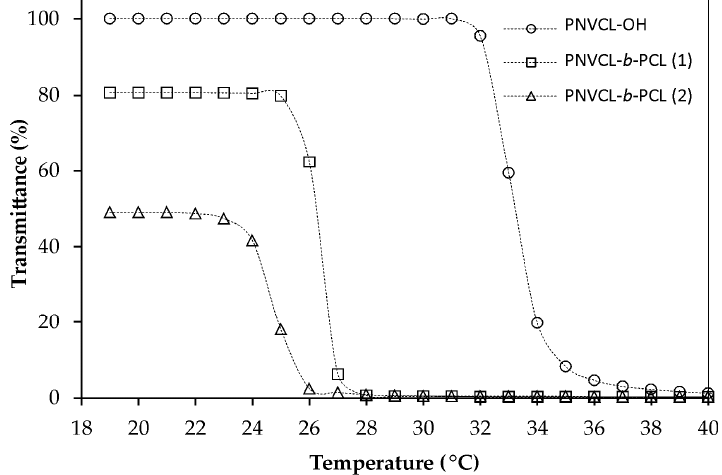
Figure 10. Effect of hydrophobic block length on the LCST of the PNVCL- b -PCL block copolymer micelles (C = 2 mg mL − 1 ).